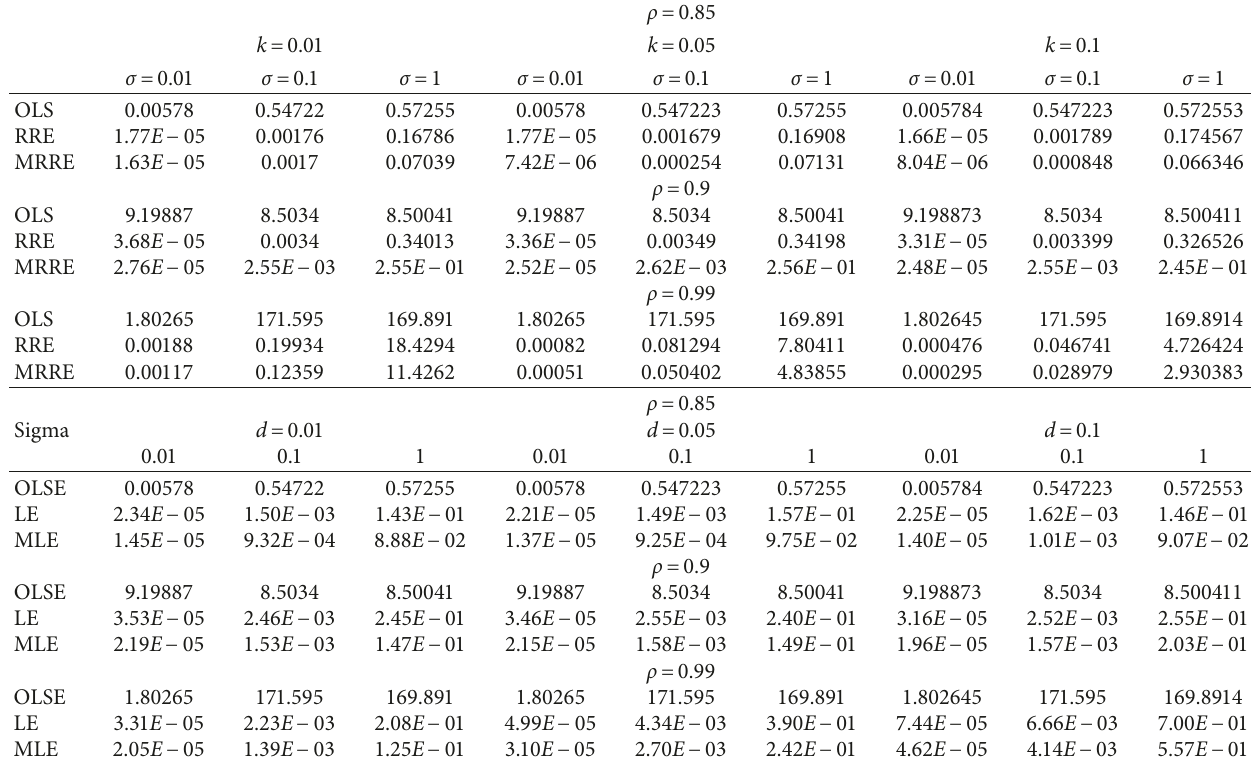
Table 5: Estimated MSE values of the OLSE, RRE, MRRE, LE, and MLE when n � 100. ρ � 0.85